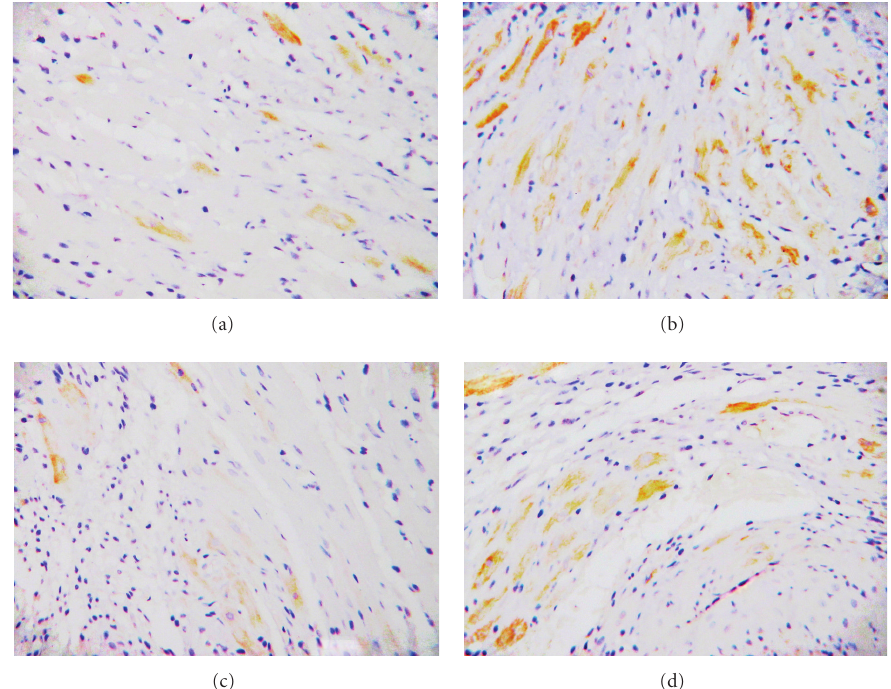
Figure 3: TH immunohistochemical staining of the infarct border zone (DAB color, 200). (a) Sham-operated group. The distribution of (cid:2) TH-positive nerve fibers is orderly. (b) Control ischemic group. TH-positive nerve fibers in ventricular muscle increased significantly it is thickened and disorderly. (c) Preischemic treatment group. (d) Delayed application group. The distribution of nerve fibers after treatment with desipramine significantly improved. The change of preischemic treatment group was more